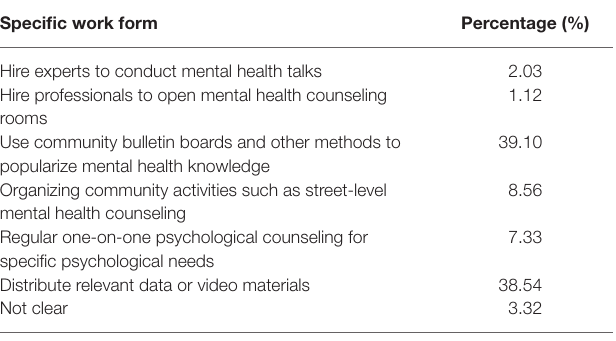
TABLE 1 | Ways of developing mental health education in the community. Specific work form